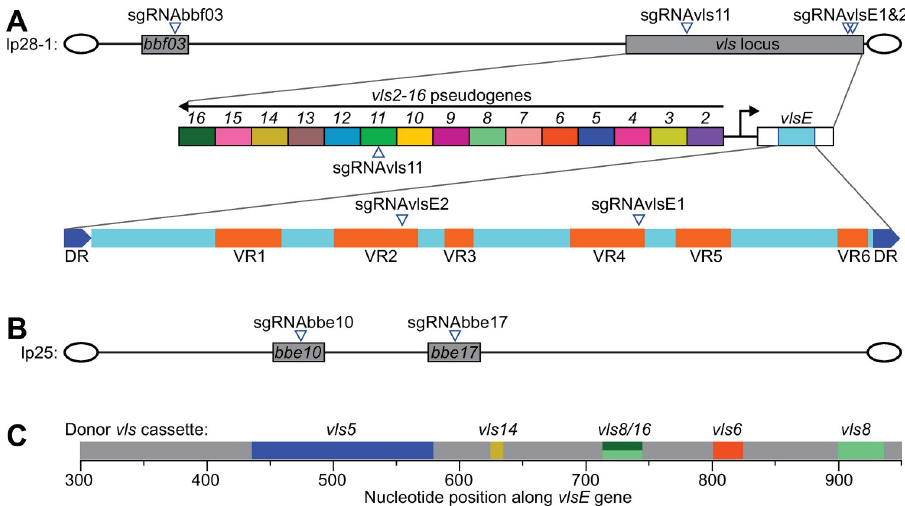
Fig 2. Locations targeted by Cas9 activity in B . burgdorferi endogenous plasmids lp28-1 and lp25. A. Top: schematic depiction of plasmid lp28-1. Marked (but not drawn to scale) are gene bbf03 and the vls locus, which were targeted by the indicated sgRNAs. The sgRNAs were used one at a time, never in combination. Middle: magnification of the vls locus. Shown (but not drawn to scale) are the expressed vlsE lipoprotein gene and the 15 silent vls cassettes. Bottom: magnified view of the vlsE1 cassette, which contains the variable regions of the expressed vlsE lipoprotein, flanked by two direct repeats (DRs). Variable regions (VRs) 1 through 6 are depicted, as well as the locations targeted by sgRNAvlsE1 and sgRNAvlsE2. Covalently closed hairpin telomeres are depicted as ovals flanking both ends of the linear plasmid. B. Same as in (A) but for plasmid lp25. Marked (but not drawn to scale) are genes bbe10 and bbe17 , which were independently targeted by the indicated sgRNAs. C. Depiction of part of the vlsE gene of strain K2. Shown in gray are sequences shared with the vlsE sequence reported for the parental strain B31. In color are divergent sequences that likely arose by recombination of the indicated silent cassettes into the expressed locus. The colors match those used for the silent cassettes in panel A. The vls8 / 16 notation signifies a sequence that could have originated from either the vls8 or vls16 silent cassette.